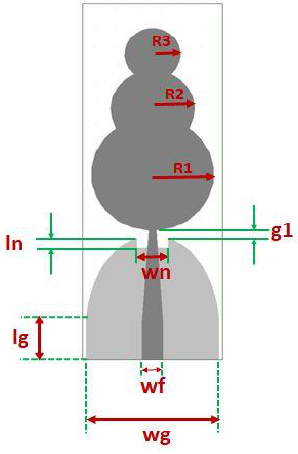
Figure 2. Schematic of the antenna linked with port 1.